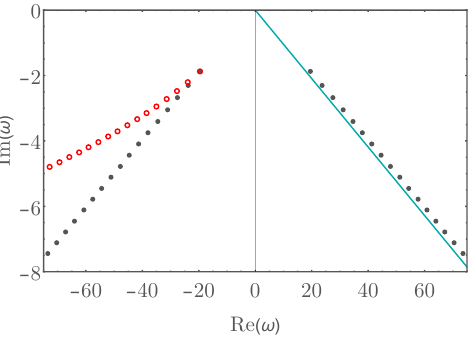
Figure 2 . The quasinormal mode spectrum for n = 30. The solid dots are numerically determined. For the modes with negative real part, the open circles indicate the prediction from our WKB analysis for modes with j ! j & n= 2. For the modes with positive real part, we have plotted the line Im( ! ) = (cid:0) (cid:25) Re( ! ), determined from the j ! j (cid:29) n= 2 analysis of the quasinormal mode n